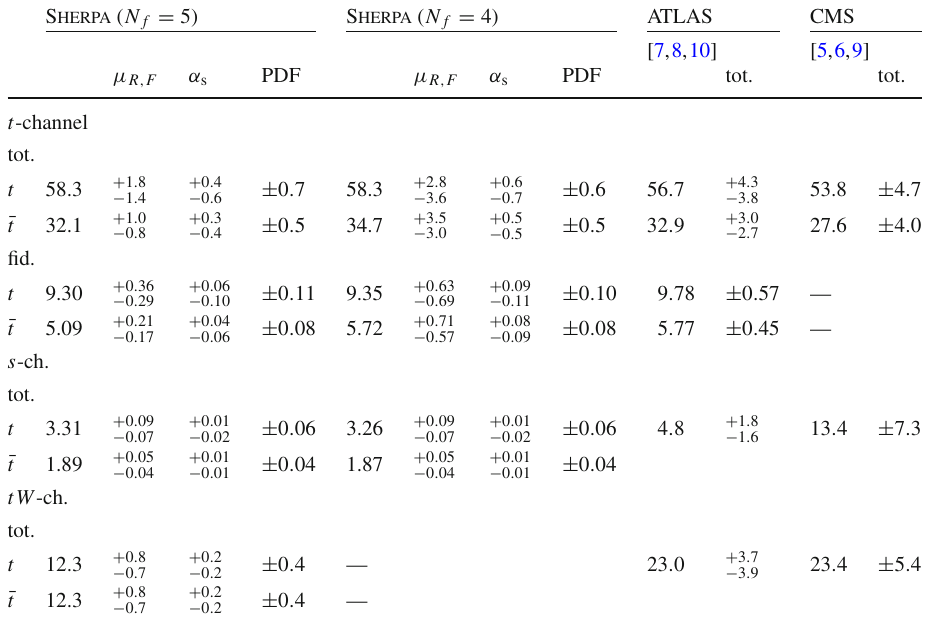
single-top production cross sections in picobarn